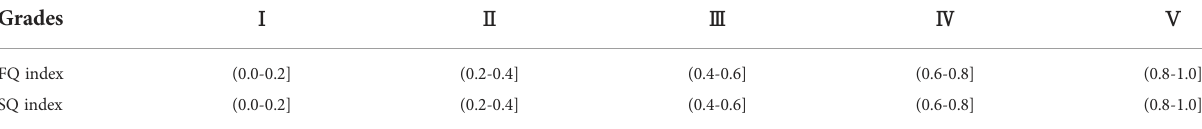
TABLE 5 The grades of FQ and SQ.